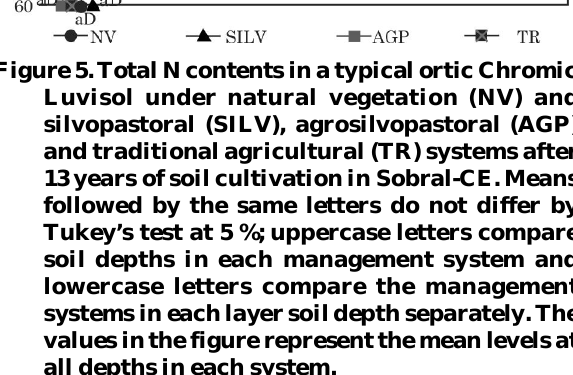
values in the figure represent the mean levels at all depths in each